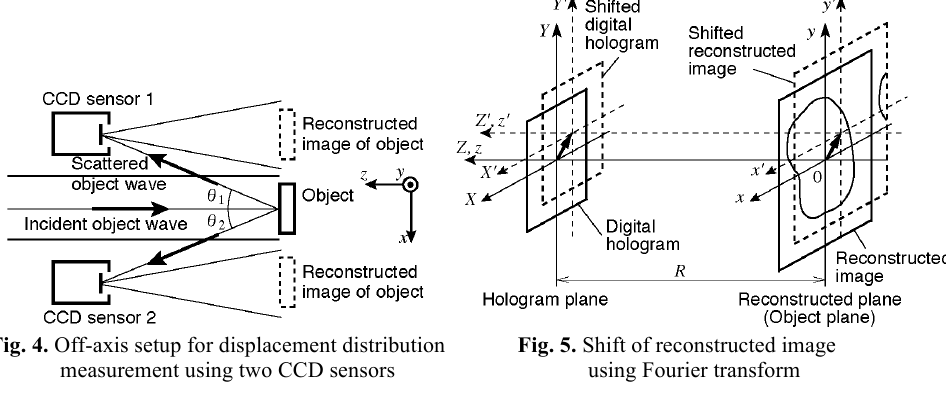
Fig. 4. Off-axis setup for displacement distribution Fig. 5. Shift of reconstructed image